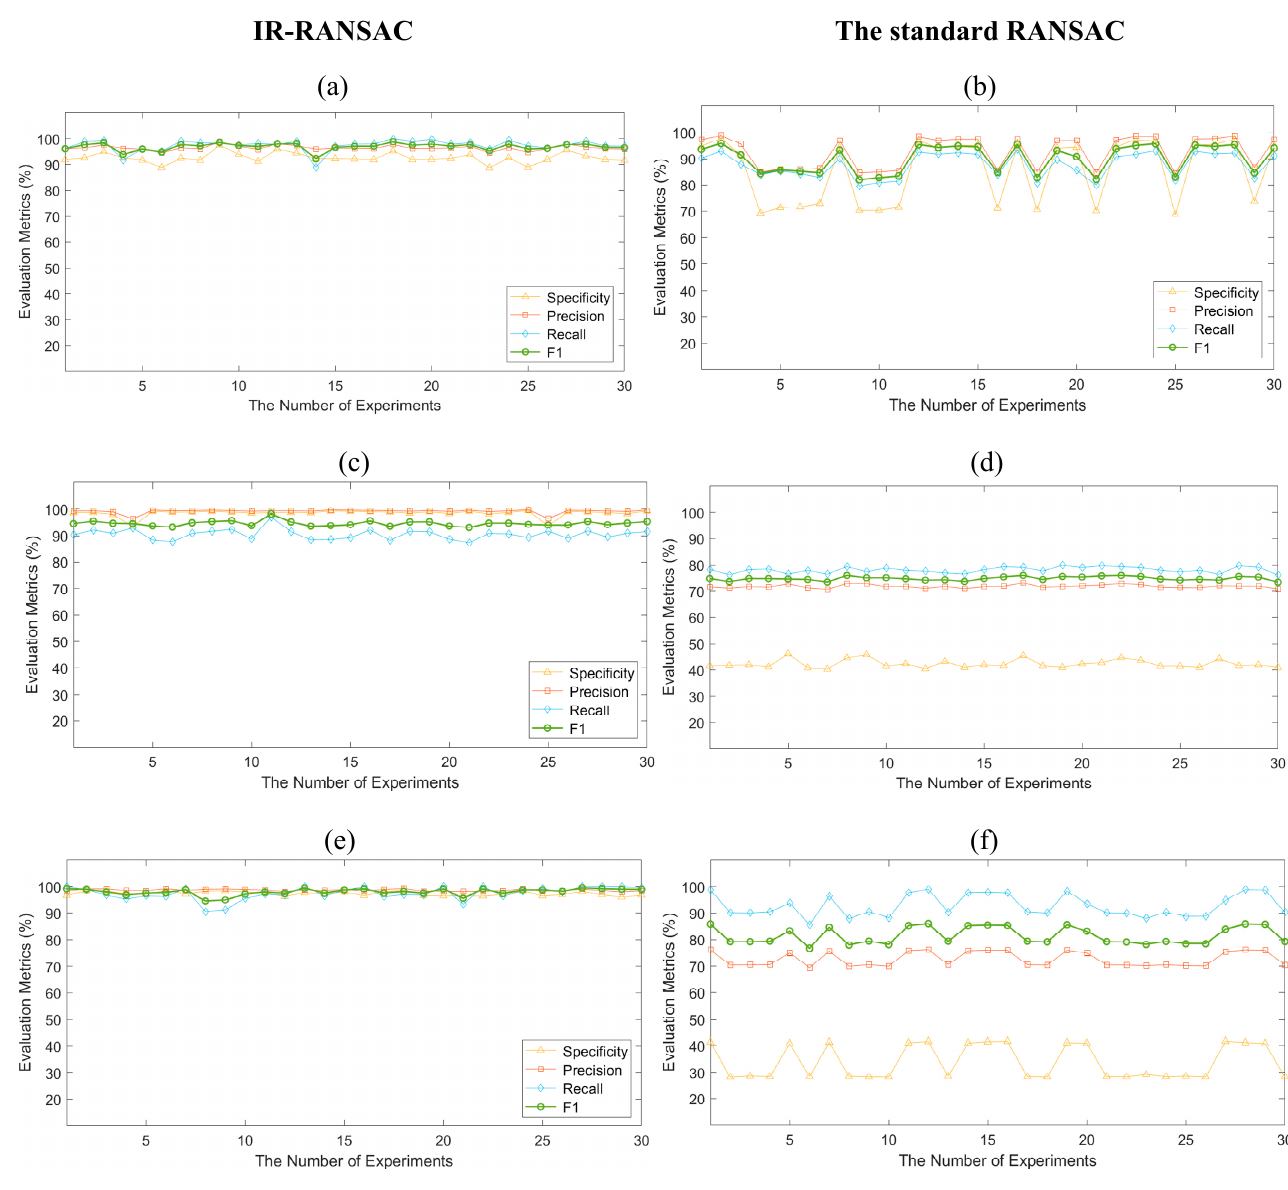
Figure 10. The evaluation results of IR ‐ RANSAC and the standard RANSAC plane removal for the three datasets: ( a , b ) the Room ‐ 1, ( c , d ) the Room ‐ 2, ( e , f ) the Room ‐ 3. Table 5. Execution times, mean (M), and standard deviation (SD) of IR ‐ RANSAC and standard RANSAC for specificity, precision, recall, and F 1 score.